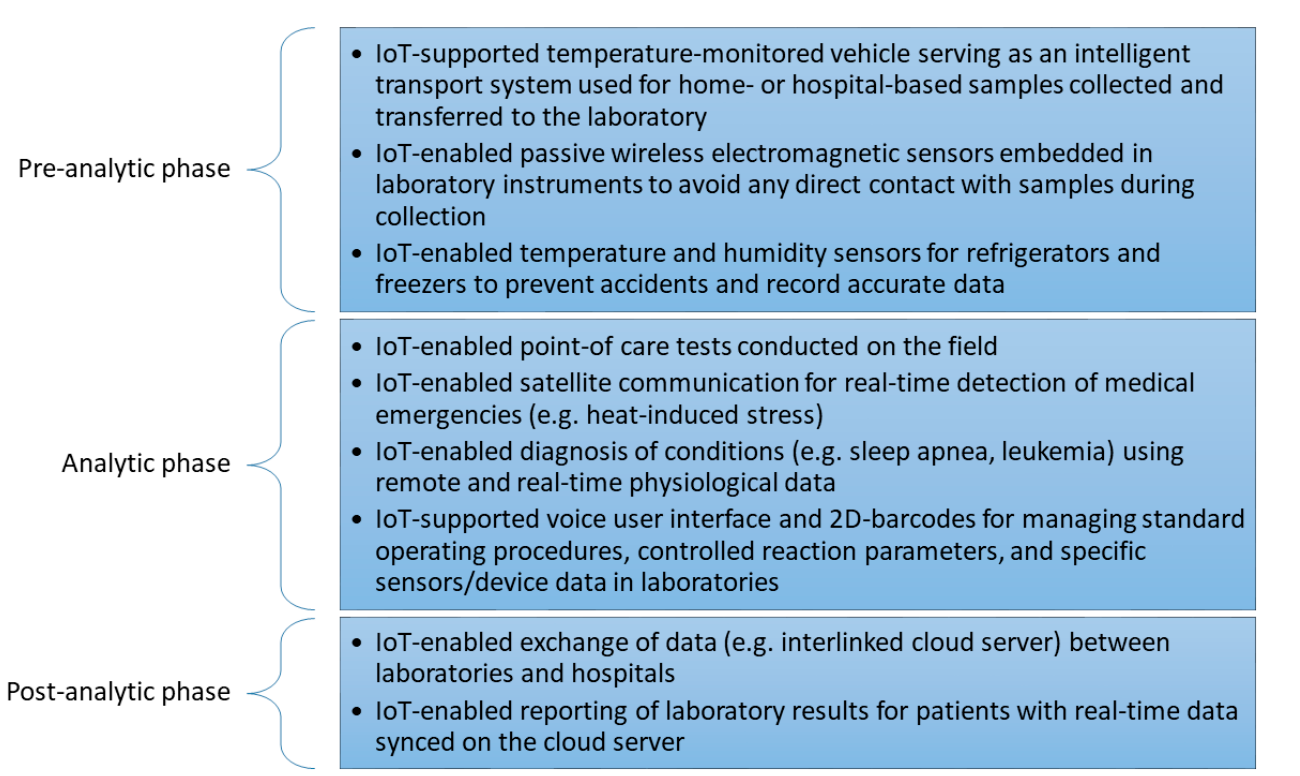
Figure 5. A bar chart of the percentage of investigations published each year since 2015.